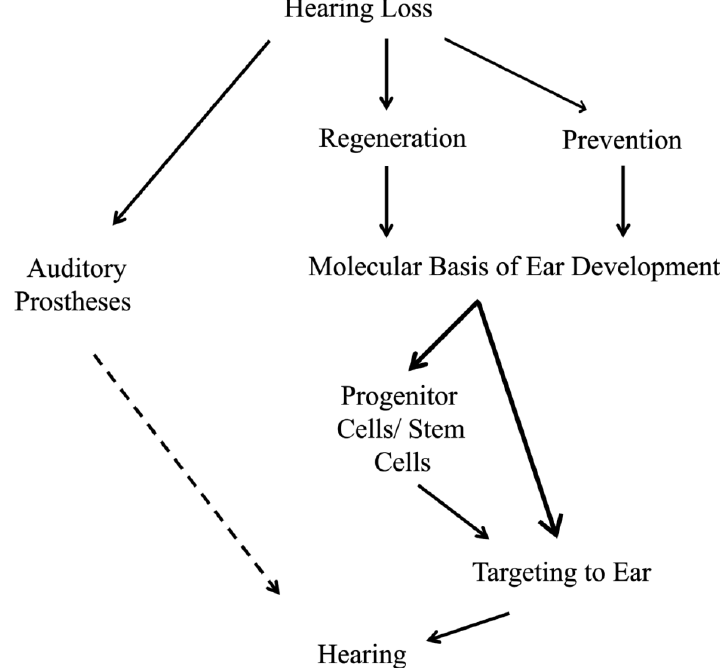
Figure 2. Hearing loss is a major global problem and patient options are limited. Current treatment to restore hearing is centered on the use of auditory prostheses; however, no current option is able to fully restore normal hearing (dashed line). Thus, perfect solutions to this growing problem include prevention of hair cell loss and when hair cell loss does occur, regeneration of damaged tissue is needed to restore full functionality. To successfully prevent the loss of hair cells or regenerate hair cells after loss, we must have a greater understanding of the molecular basis of ear development, specifically, what genes are needed to form and to maintain hair cells. Upon elucidating these minimal essential factors, it may be possible to directly target inner ear tissues. In the case of prevention, (cid:76)(cid:81)(cid:70)(cid:85)(cid:72)(cid:68)(cid:86)(cid:76)(cid:81)(cid:74)(cid:3) (cid:87)(cid:75)(cid:72)(cid:3) (cid:75)(cid:68)(cid:76)(cid:85)(cid:3) (cid:70)(cid:72)(cid:79)(cid:79)(cid:182)(cid:86)(cid:3) (cid:81)(cid:68)(cid:87)(cid:88)(cid:85)(cid:68)(cid:79)(cid:3) (cid:80)(cid:68)(cid:76)(cid:81)(cid:87)(cid:72)(cid:81)(cid:68)(cid:81)(cid:70)(cid:72)(cid:3) (cid:80)(cid:72)(cid:70)(cid:75)(cid:68)(cid:81)(cid:76)(cid:86)(cid:80)(cid:86)(cid:3) (cid:80)(cid:68)(cid:92)(cid:3) (cid:69)(cid:72)(cid:3) (cid:86)(cid:88)(cid:73)(cid:73)(cid:76)(cid:70)(cid:76)(cid:72)(cid:81)(cid:87)(cid:17) Once hair cells are lost, manipulation of inner ear supporting cells may be possible to form new hair cells. On the other hand, an alternative source of cells, such as stem cells could be first manipulated to form hair cell-like cells and then targeted to the damaged tissue to restore